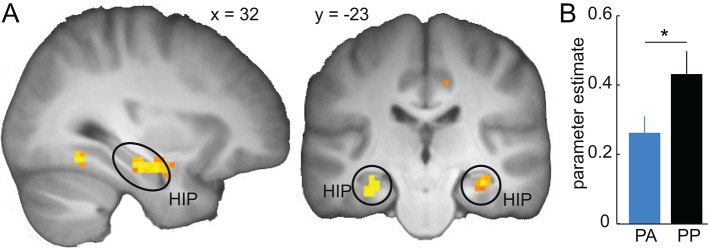
Similarity-based prediction error responses in the hippocampus during generalization.(A) Across both groups, activity in the hippocampus is significantly correlated with model-derived prediction errors during generalization test. T-map from one-sample t-test is thresholded at P < 0.05, FWE whole brain corrected and overlaid on a T1-weigthed image averaged across subjects. (B) Prediction error-related activity in the hippocampus is significantly reduced by D2R blockade (two-sample t-test, t = -2.12, P = 0.02). Error bars are SEM for N = 25 (PA) and N = 21 (PP).